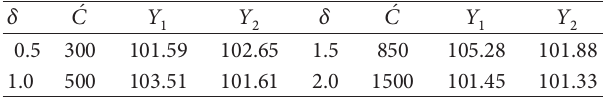
Table 7: PRE of proposed compromise allocation to individual optimum